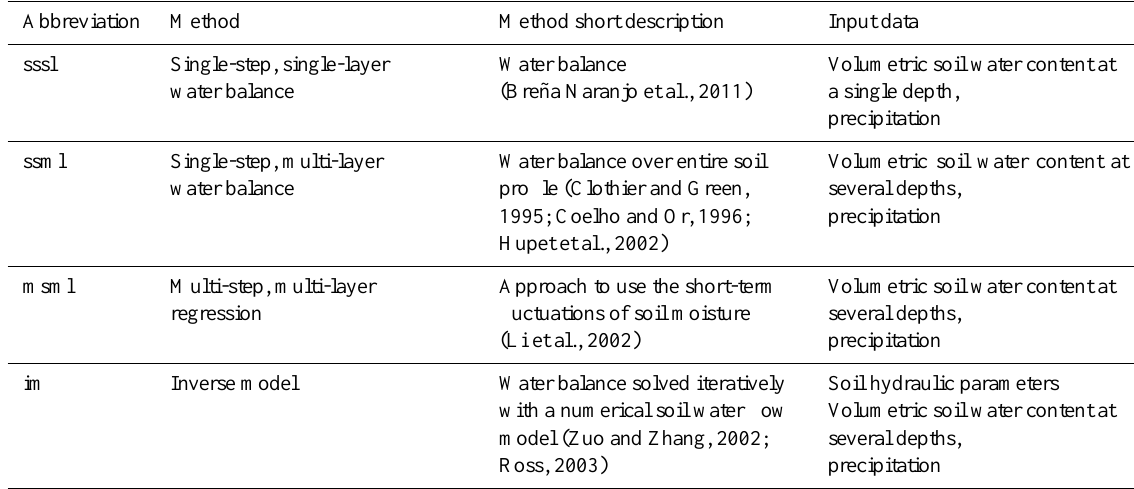
Table 1. The abbreviation and full name of the methods for further use, overviews of the four applied data-driven methods, and the required input